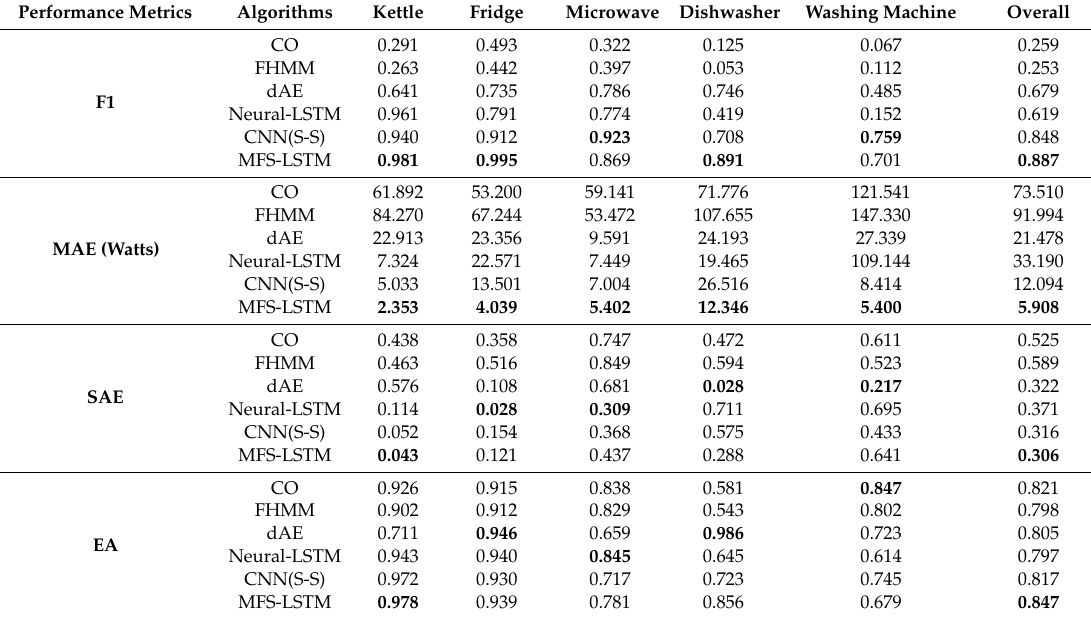
Figure 10. Comparison of disaggregation algorithms in the seen scenario based on the UKDALE dataset. Table 7. Performance evaluation of disaggregation algorithms in the seen